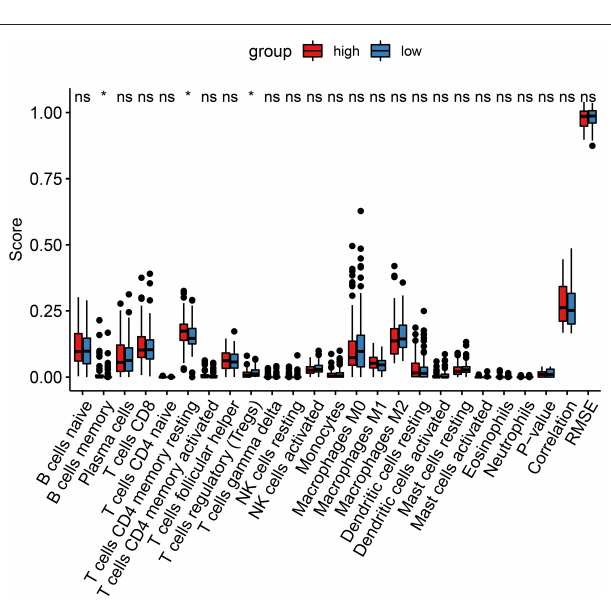
nominal p -value < 0.05 and FDR < 0.05 were found in the low- risk group, indicating that there were no pathways significantly enriched in the low-risk